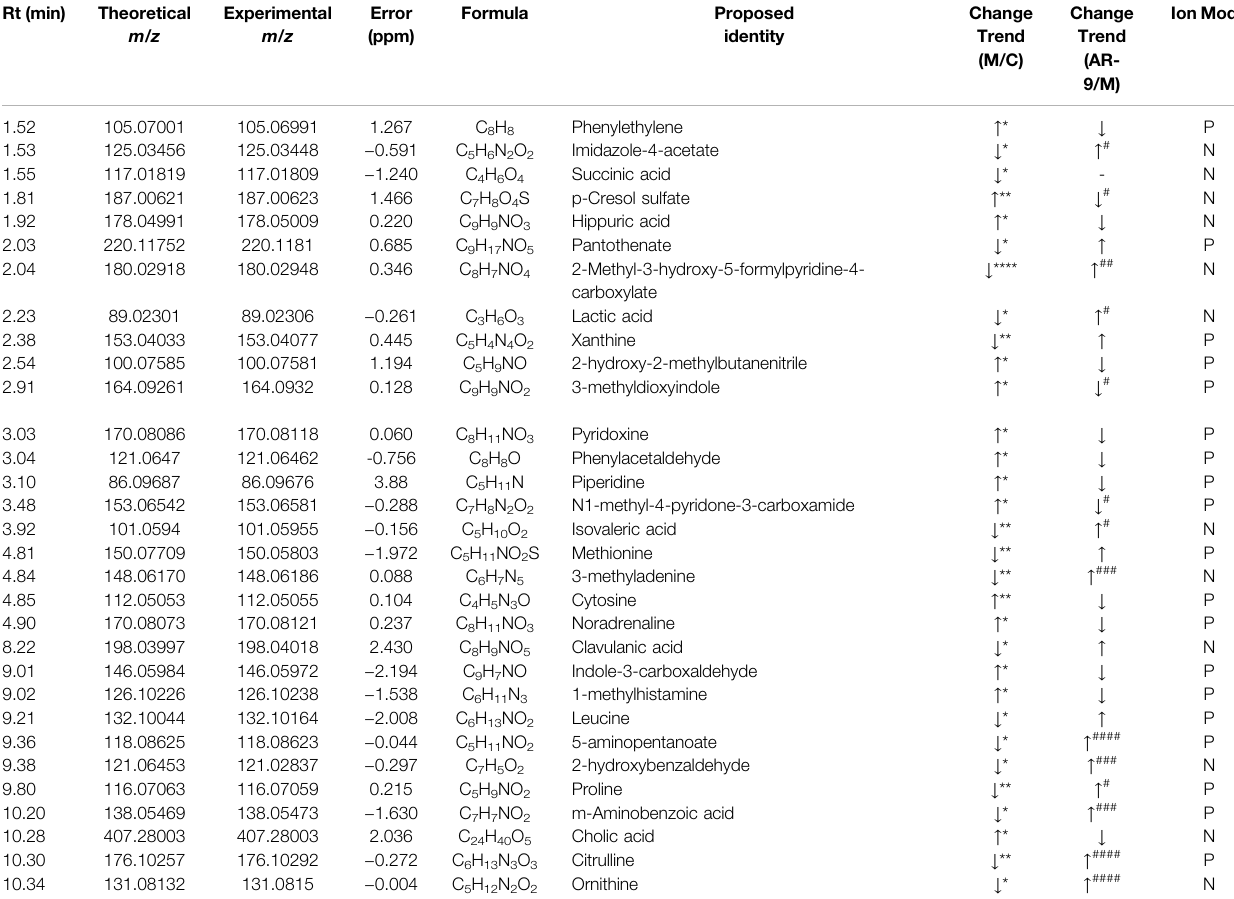
TABLE 1 | Identi fi ed potential biomarkers regulated by AR-9. Rt